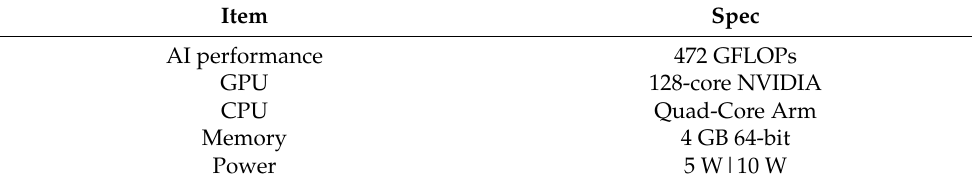
Table 1. Technical specifications of Jetson